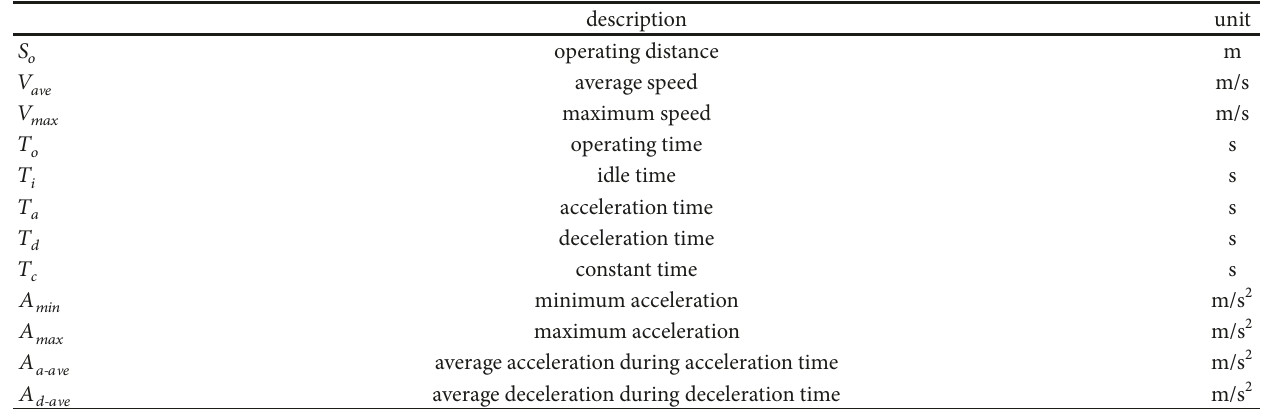
Table 1: Kinematics segment features parameters.